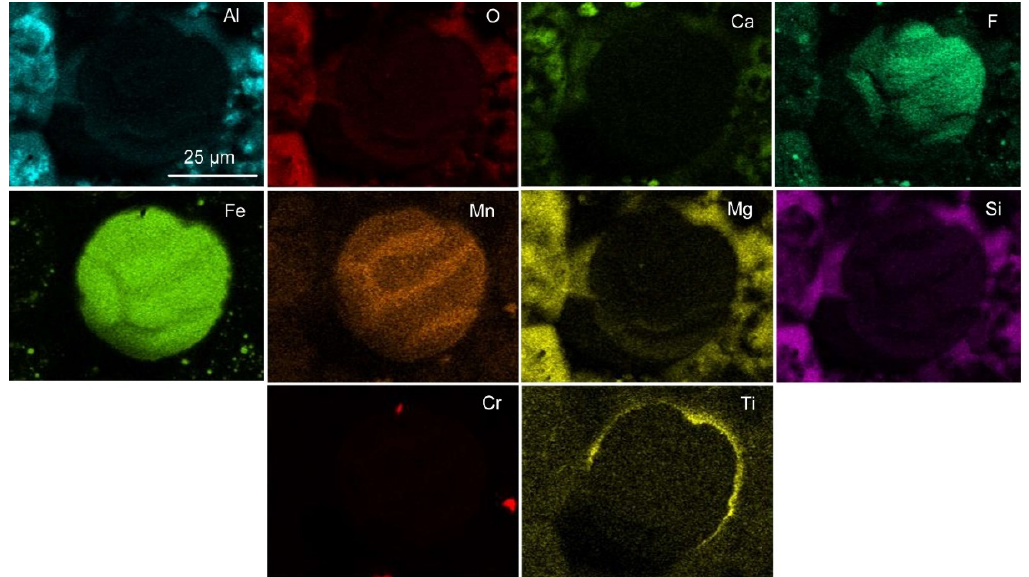
Figure 12. EDX map of marked area in Figure 10c: MP5 slag sample.